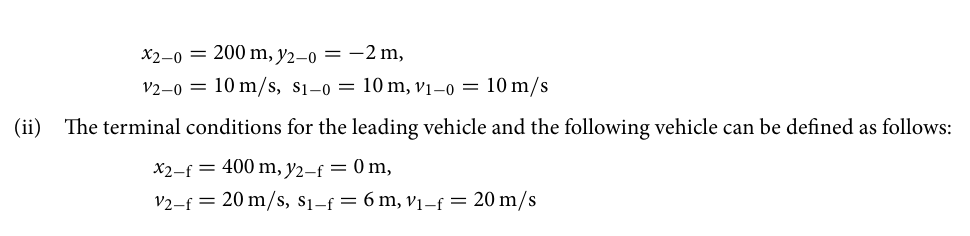
Figure 2. Trajectory optimization and driving states of the leading